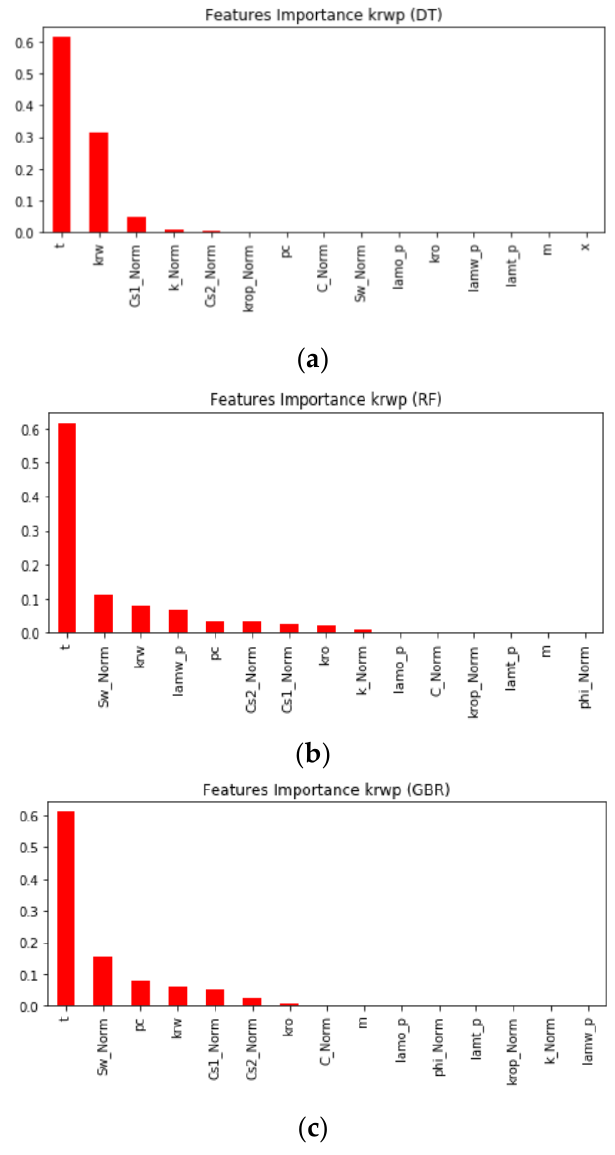
Figure 12. Features importance of ( a ) DT, ( b ) RF, and ( c ) GBR models for predicting k rwp . Table 9. Model performance evaluation of two phases dataset for k rwp